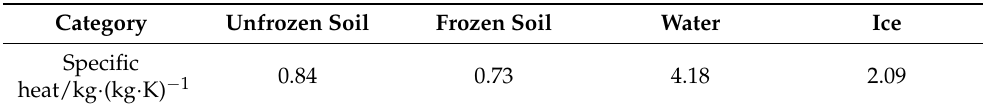
Table 2. Specific heat values of soil skeleton and water